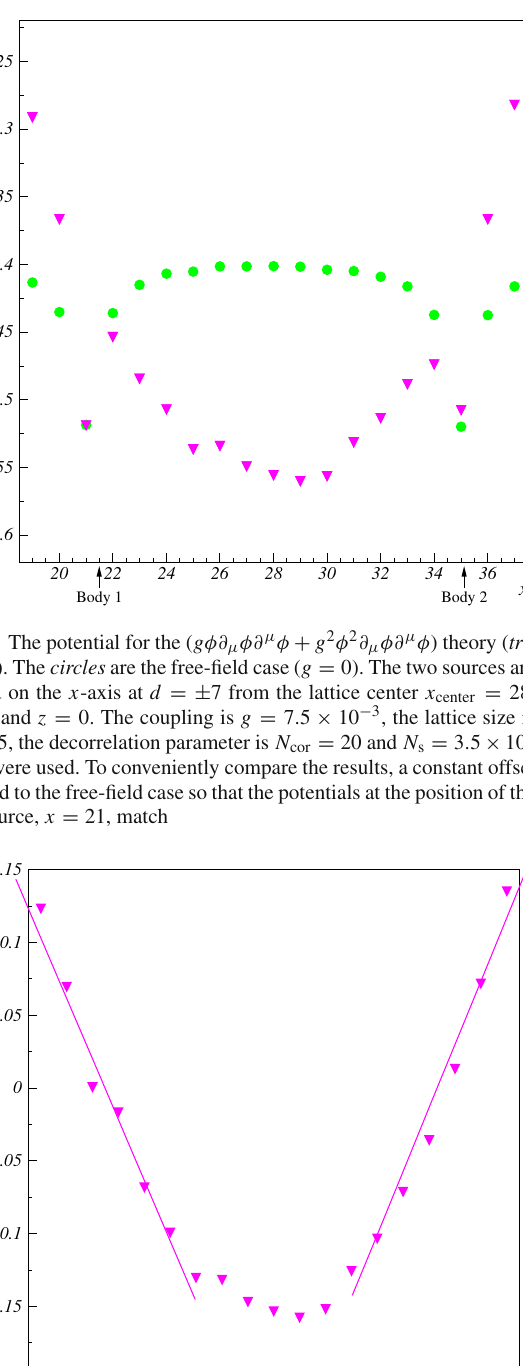
a flux tube linking the two sources. This collapse is caused by strong non-perturbative field self-interactions: the gluons strongly attract each other toward the region of their